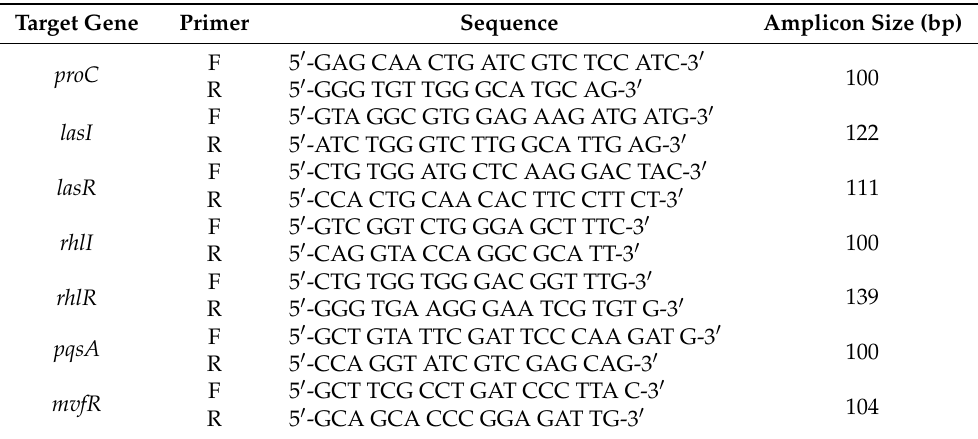
Table 1. List of genes and their respective primers used in the RT-qPCR assay. Target Gene Primer Sequence Amplicon Size